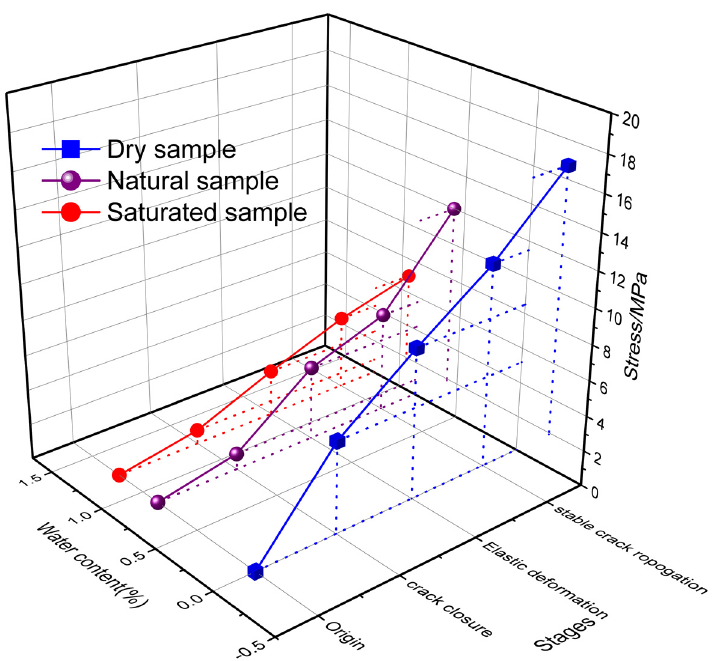
Figure 16. The effect of water on stress in different stages of dry, natural, and saturated coal